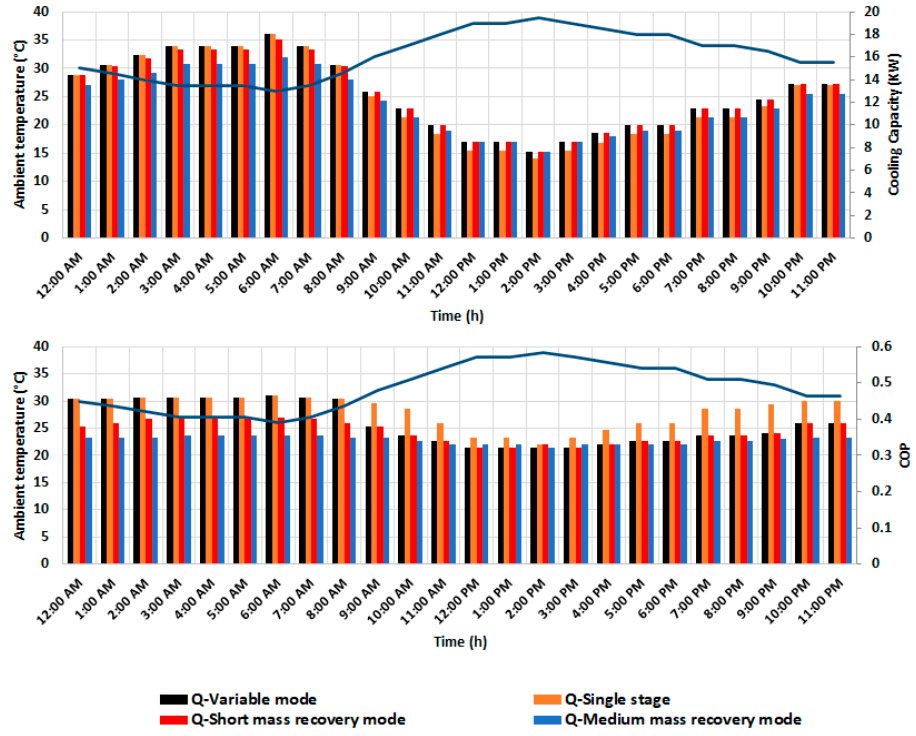
Figure 22. Measured ambient temperature and expected cooling capacity and COP for various modes (day 2).